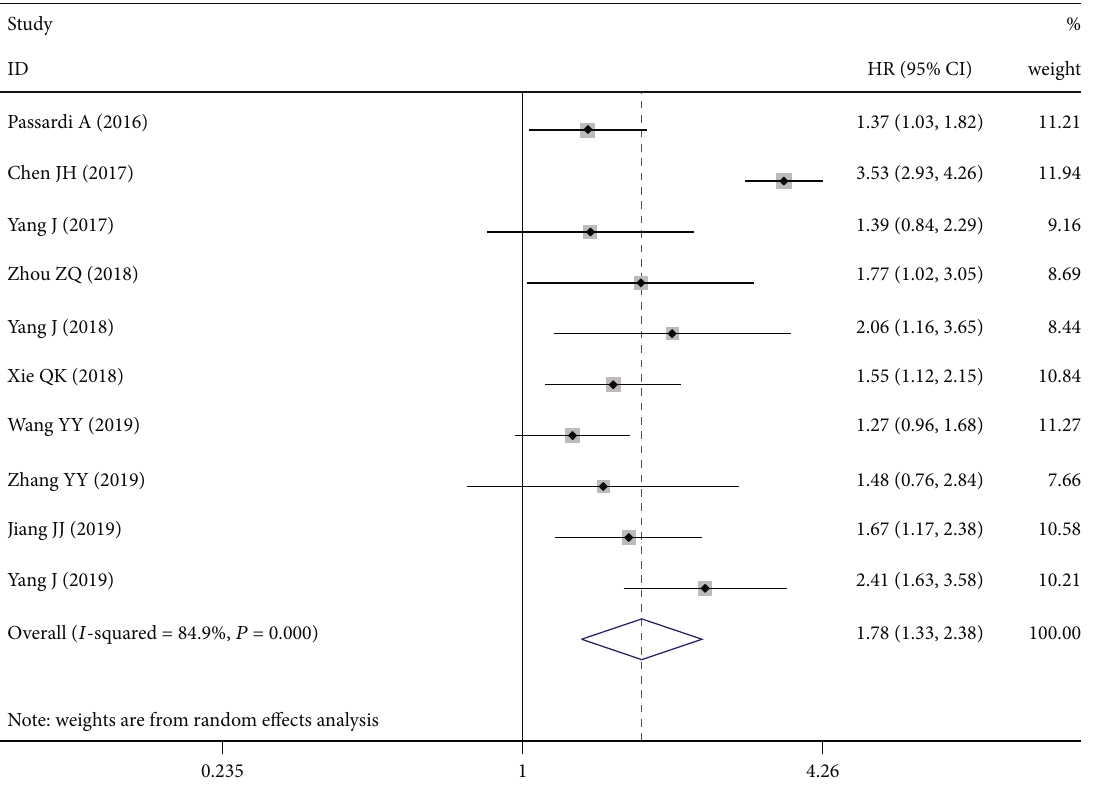
Figure 2: Forest plot for the association between SII and overall survival. SII: systemic immune-in fl ammation